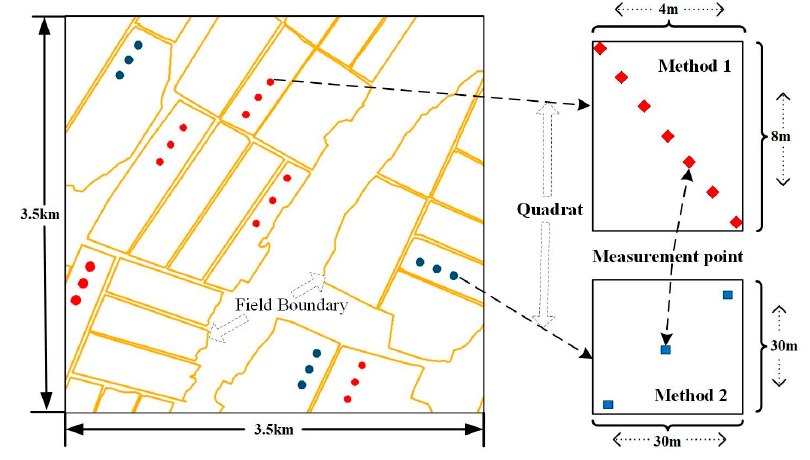
Figure 2. The layout of quadrats and samples in 2014 and 2015.